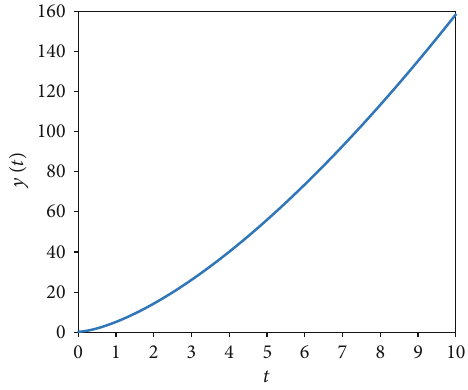
Figure 1: Curve of y ð t Þ in Example